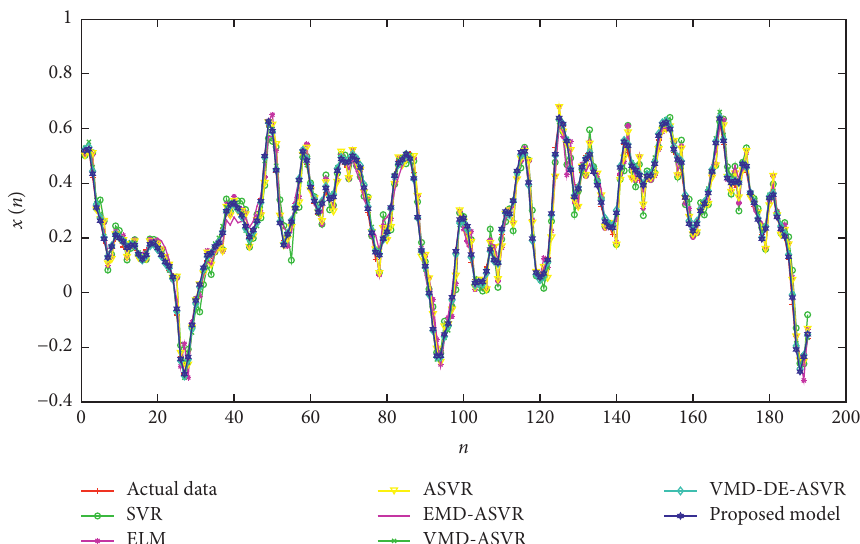
Figure 16: Prediction results for each model of data set B.